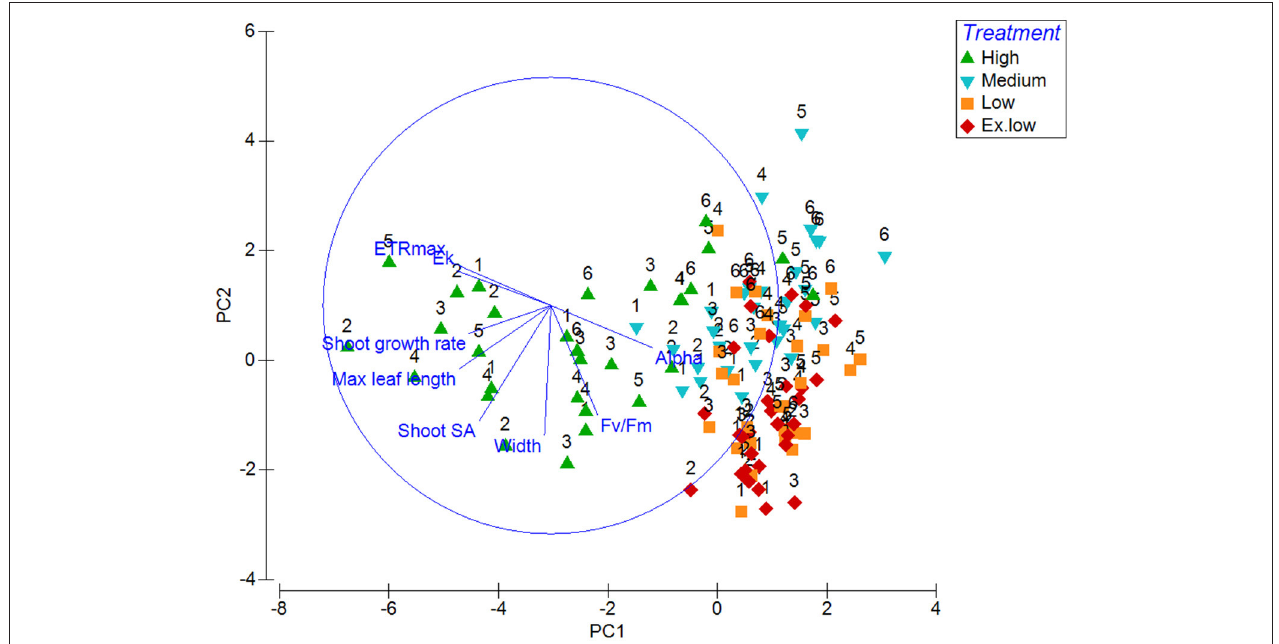
FIGURE 4 | Principal Component Analysis graph of morphological (leaf length, width, shoot surface area and shoot growth) and photophysiological (Alpha, maximum electron transfer rate, minimum saturation irradiance, and effective quantum yield) responses with treatment and week (starting from week 1) as factors.